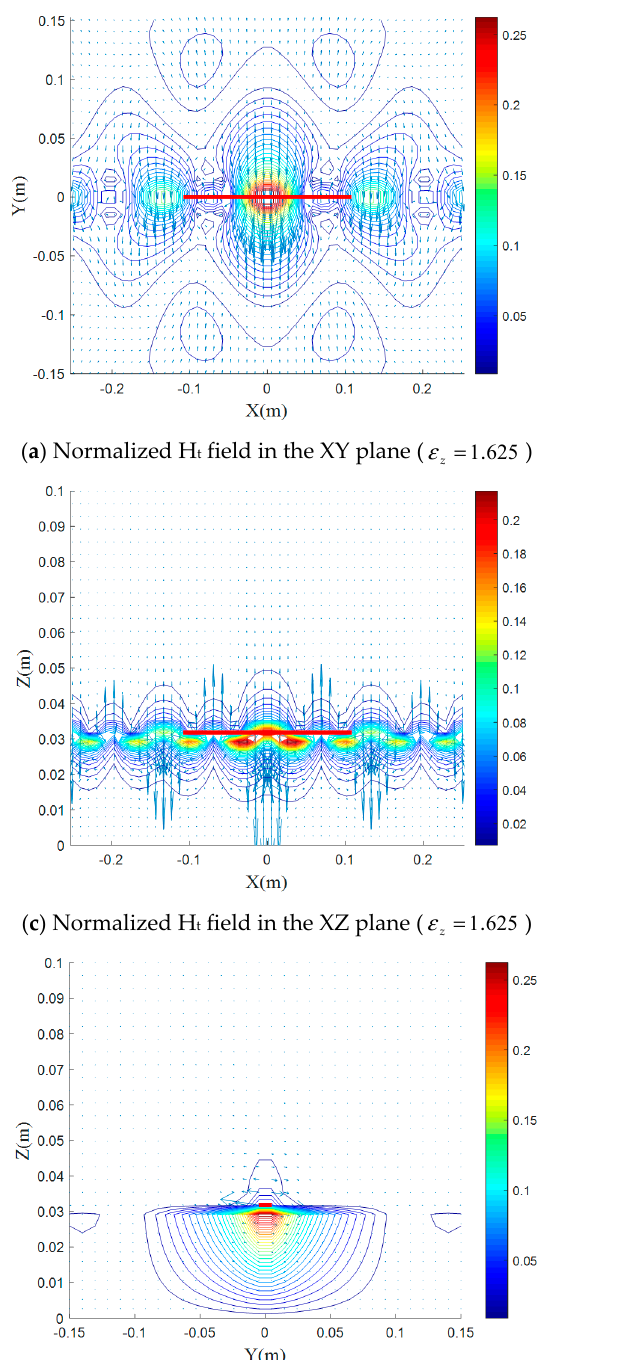
ε with 253 . = ε , 1 = μ and 1 = μ in the z t z t